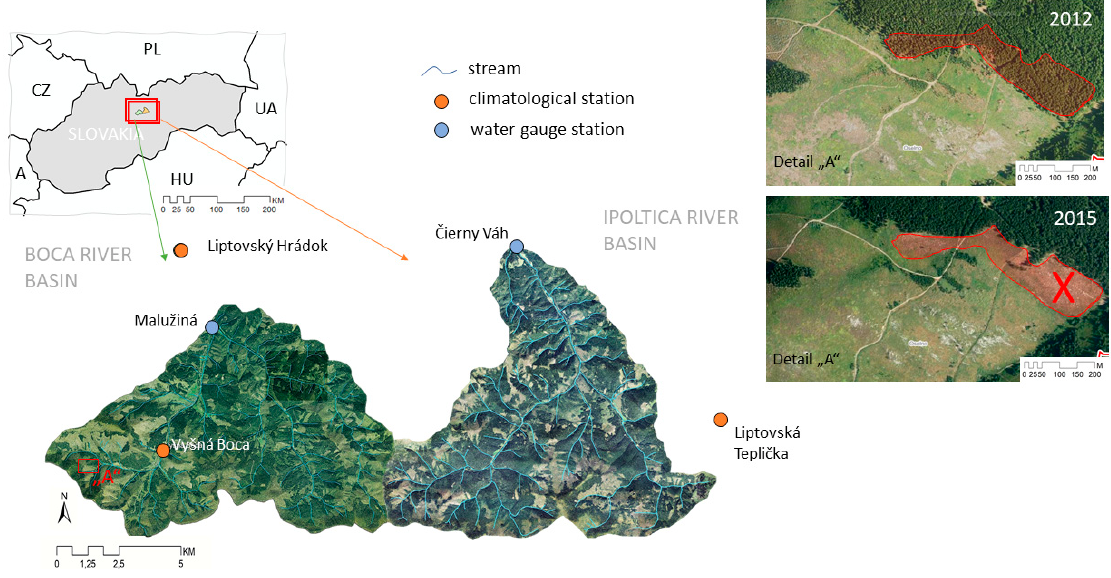
Figure 1. Location map of the basins analysed (© GKÚ, NLC; Slovakia, 2017–2019) and illustration of the state of the deforestation on the Boca River basin in 2015.